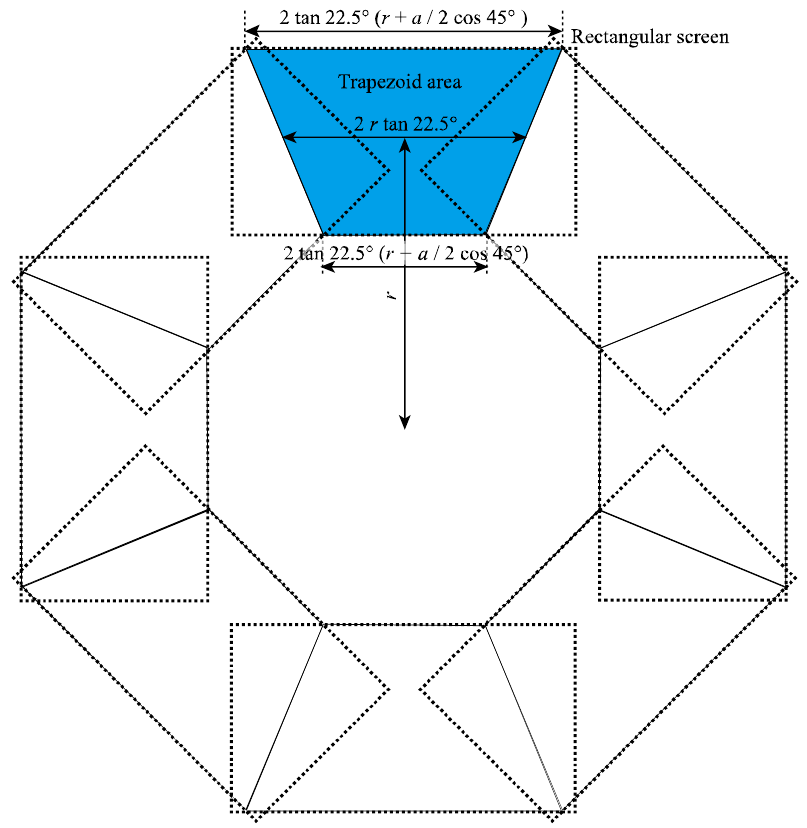
Figure 6. Stitching of screens of LFDs (top view and drawn in an orthographic projection).